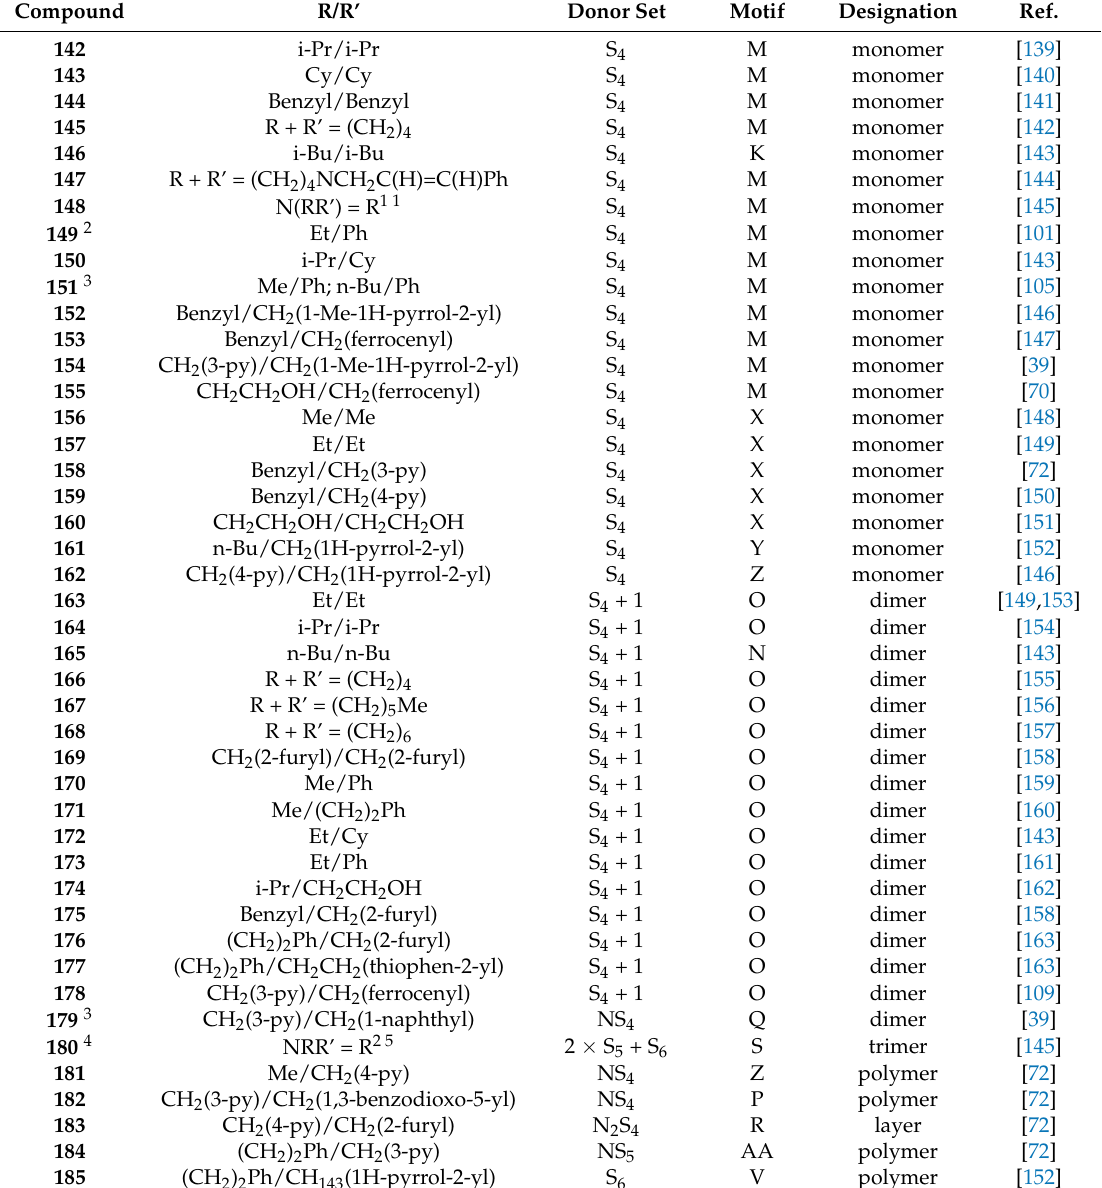
Table 5. Summary of the general features of Hg(S 2 CNRR’) 2 structures 142 – 185